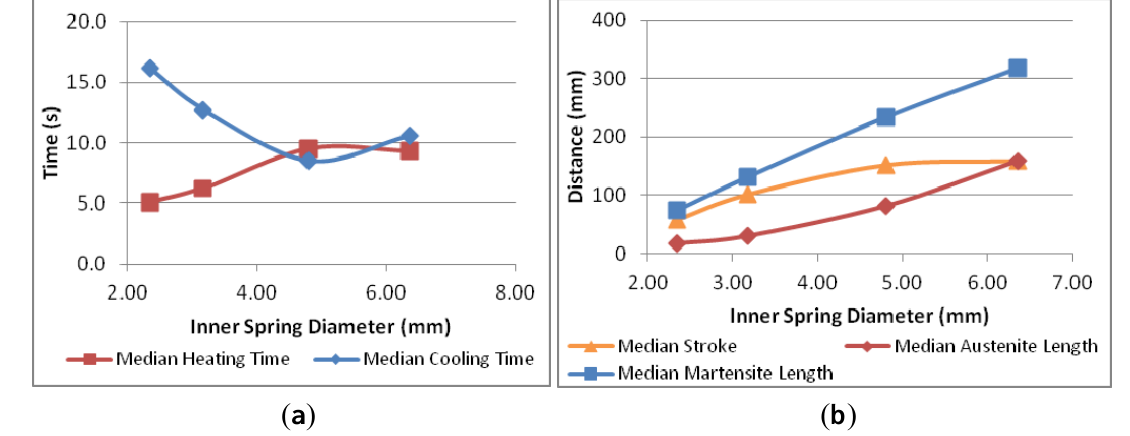
Figure 5 . Experimental results from the spring diameter manipulation. ( a ) (Left) The averaged heat and cooling times. ( b ) (Right) The averaged strokes, martensite lengths and austenite